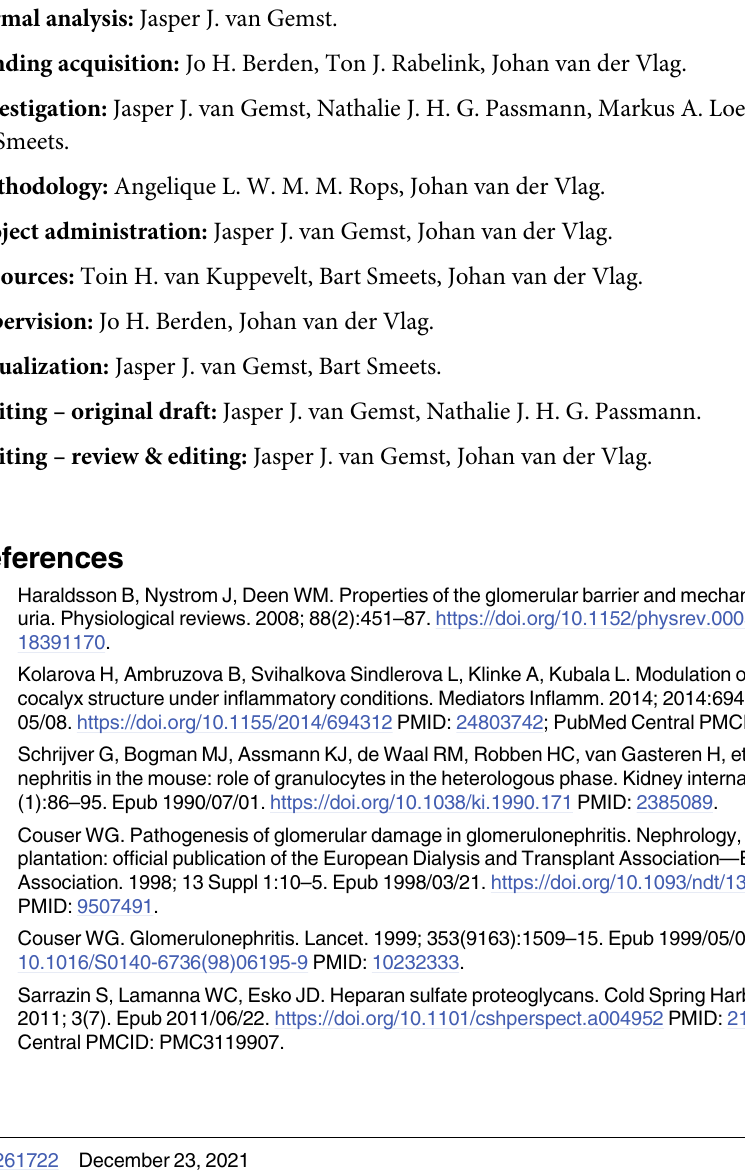
S3 Fig. Representative images of periodic acid-Schiff and hematoxylin stained renal sec- tions. Images illustrate what was scored as normal glomeruli, < 50% affected glomeruli, or > 50% affected